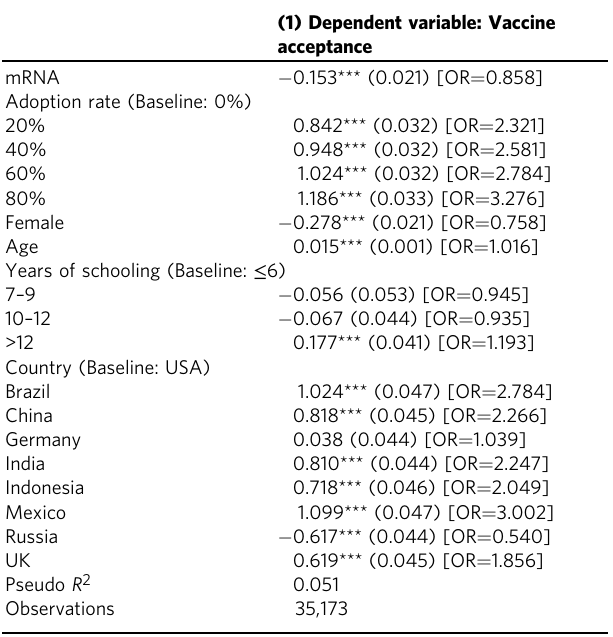
Notes: Table reports estimates from multivariate ordered logistic regression model. The dependent variable is vaccine acceptance, which takes on fi ve values (0 = “ Very unlikely ” , … , 4 = “ Very likely ” ). Estimated coef fi cients are shown, with standard errors in parentheses